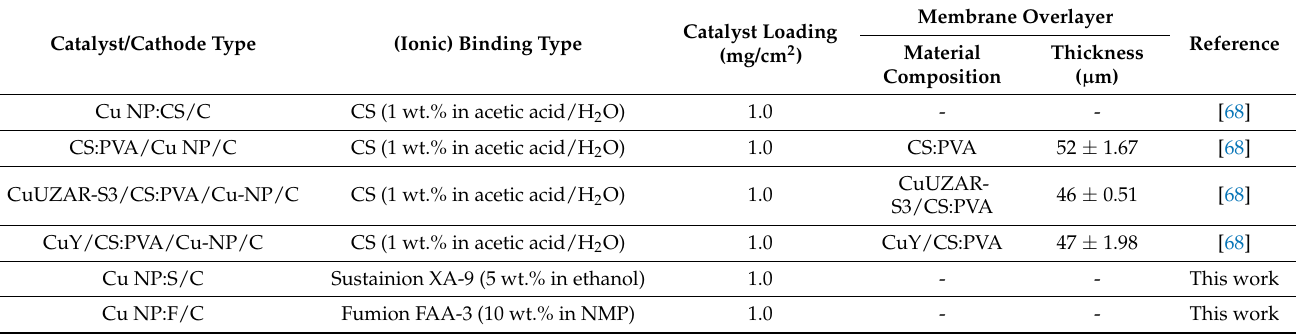
Table 1. Cu-based GDEs and MCEs for the production of C 2 H 4 in KOH alkaline media prepared in our laboratory as a function of binder in the catalytic layer and the membrane overlayer composition and thickness. A 200 µ m thick Toray carbon paper served as the supporting of the Cu-based electrocat- alysts. References in literature in this regard are collected in Table S2 in the Supplementary